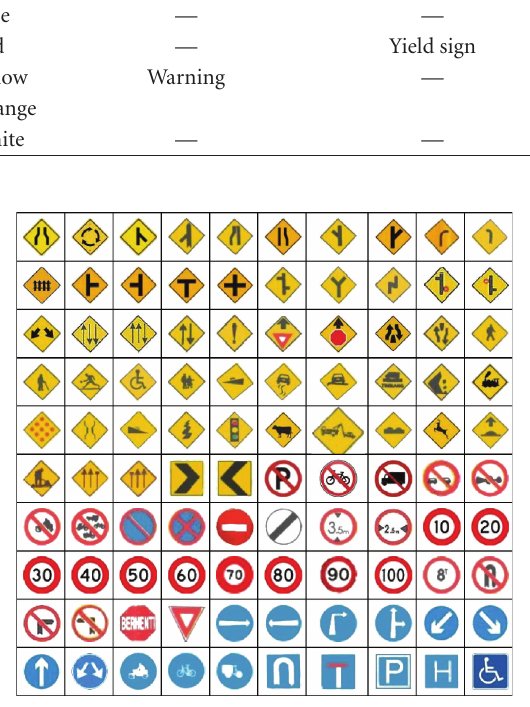
Figure 2: 100 classes of Malaysia tra ffi c signs.